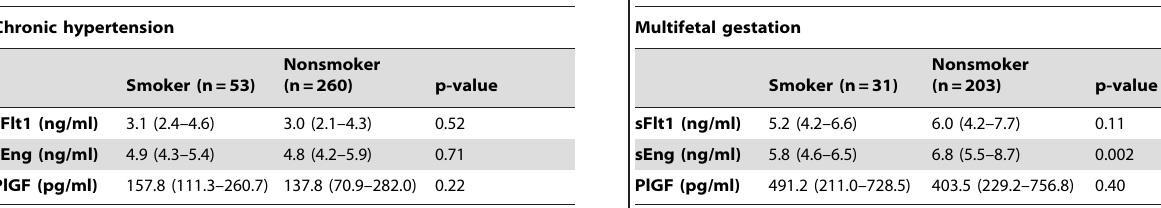
Table 3. Comparison of angiogenic factors in pregnant women with chronic hypertension: smokers versus nonsmokers.*